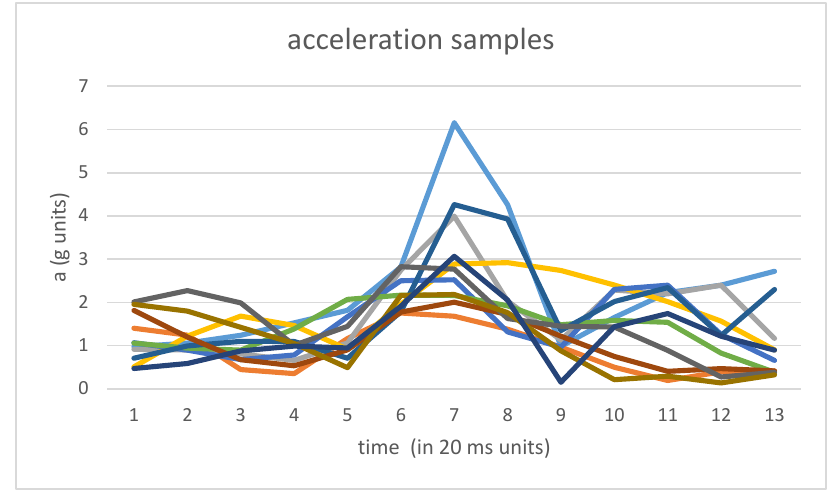
Figure 2. Acceleration samples around outliers corresponding to slow walking steps. Each color represents a different sample.